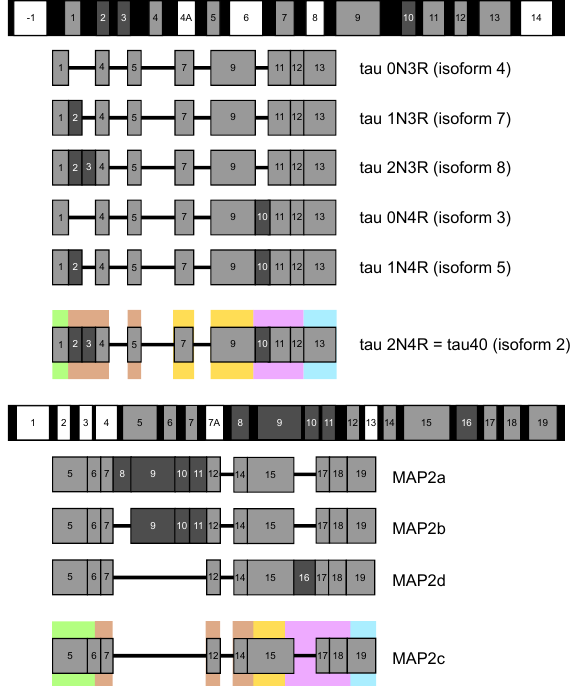
Figure 1. Organization of the DNA sequences of tau (top) and MAP2 (bottom) and splicing isoforms expressed in brain. Exons not expressed in brain isoforms are shown in white, exons expressed in all isoforms are shown in light gray, and exons expressed in some isoforms are shown in dark gray. Regions of isoforms discussed in this review are shown in boxes of different colors. The exons of tau and MAP2 are numbered according to Cailet-Boudin et al. [4] and Sündermann et al. [45], tau isoforms are numbered according to the National Center for Biotechnology Information (NCBI) RefSeq